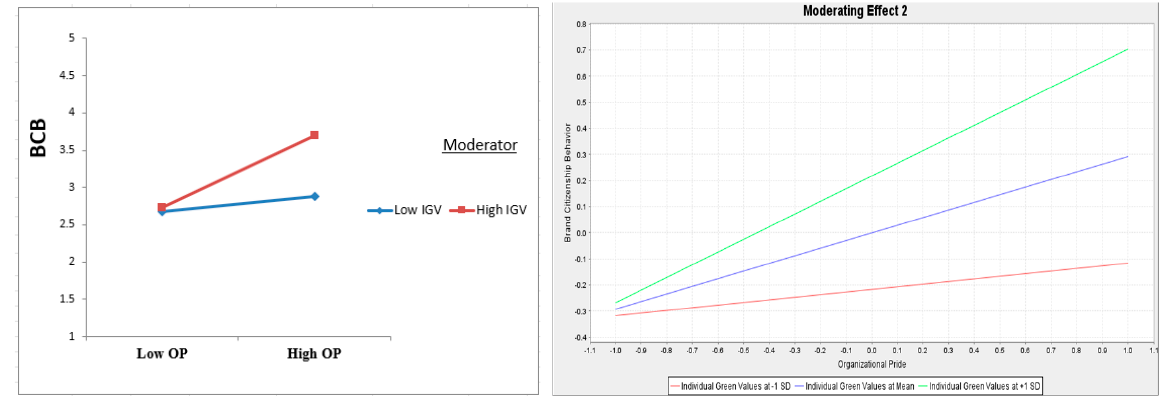
Figure 4. Interaction-plot (IGV moderation between OP and BCB).